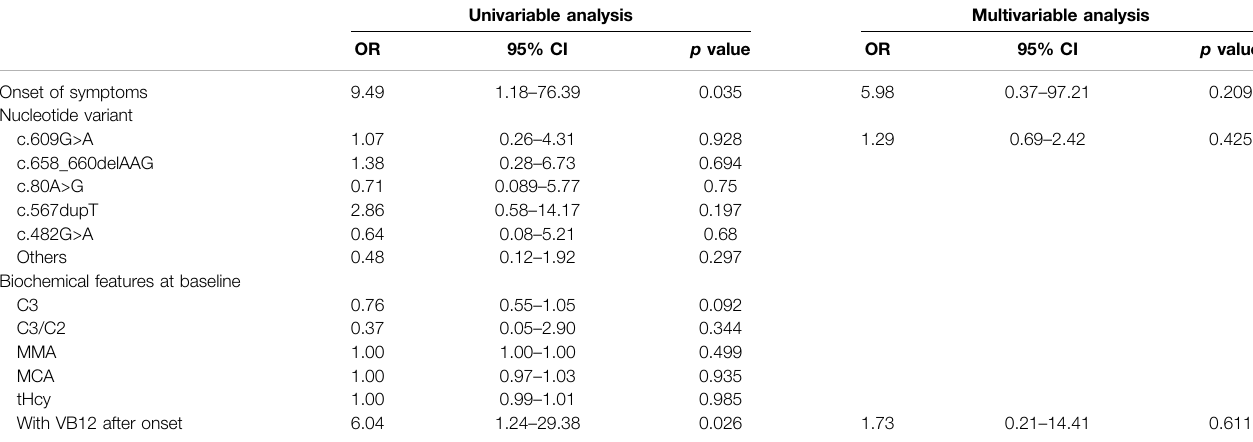
TABLE 7 | Univariate and multivariate analysis of predictors for